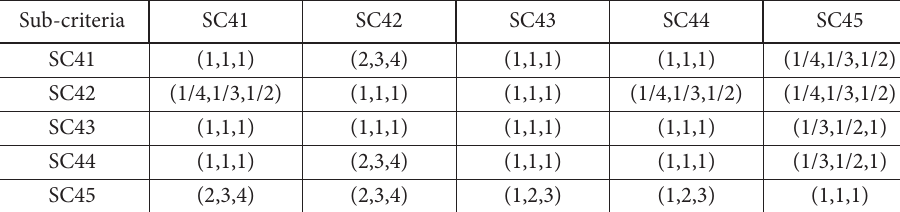
Table 7. Fuzzy comparison matrix for sub-criteria of MC4